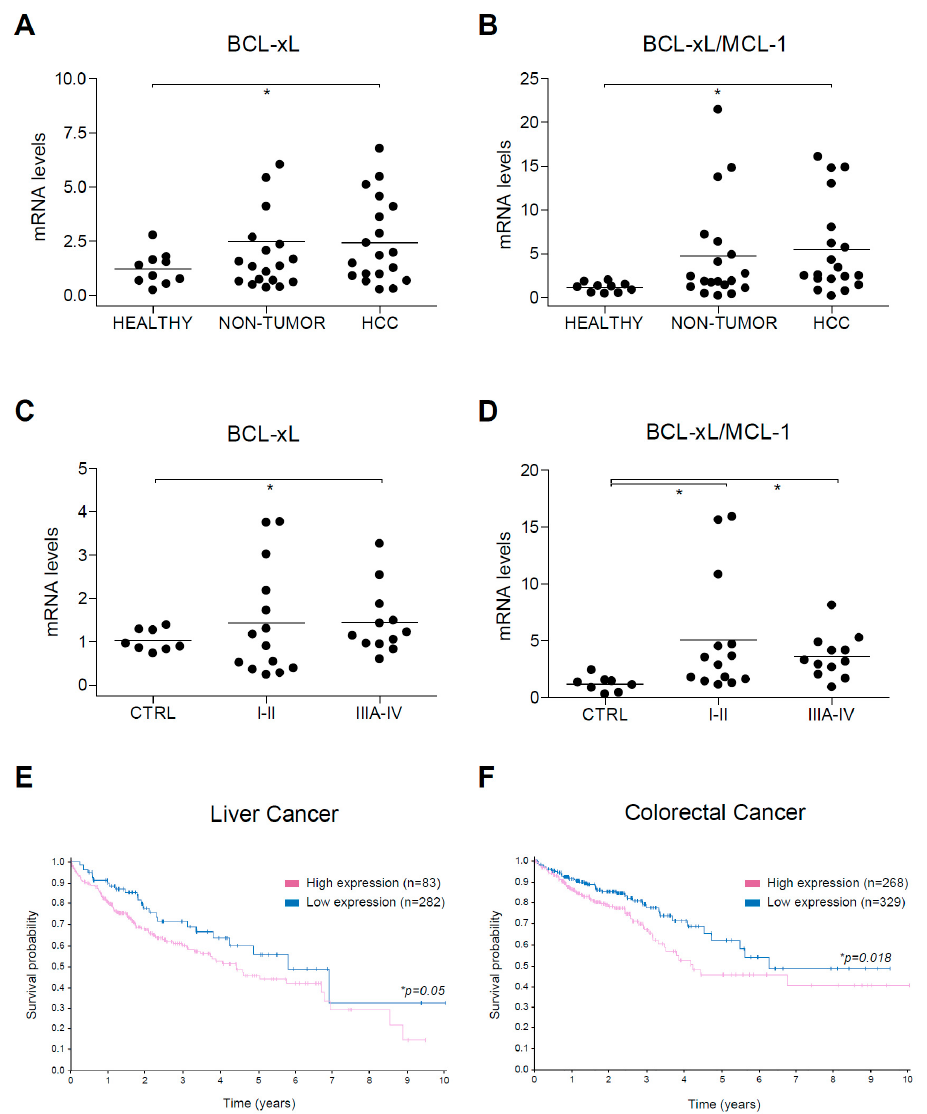
Figure 8. Alterations in BCL-xL mRNA levels and BCL-xL/MCL-1 ratio in HCC patients. ( A ) BCL-xL and ( B ) BCL-xL/MCL-1 mRNA levels were measured by qPCR in healthy liver (n = 10) and in cirrhotic and tumoral tissue from HCC patients (n = 12) with Hepatitis C virus (HCV) and/or Ethanol (EtOH etiology. * p < 0.05 vs. control. ( C ) BCL-xL and ( D ) BCL-xL/MCL-1 mRNA levels were measured by qPCR in a commercial mRNA array with healthy liver (n = 8) and tumoral tissue from HCC patients in different stages (I-II, n = 14; IIIA-IV, n = 12). ( E,F ) Representation of survival probability depending on BCL-xL expression (blue, high; purple, low) in patients with liver and colorectal cancer, respectively.